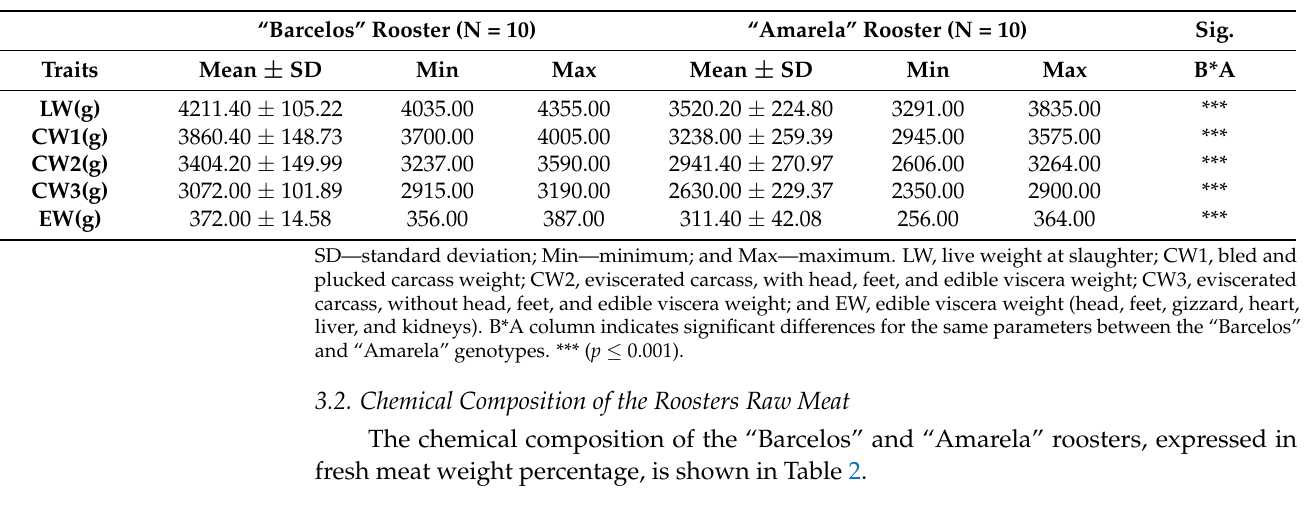
Table 2. Effect of breed and rooster pieces, breast, and drumstick in the chemical composition of “Barcelos” and “Amarela” roosters (expressed in % weight of fresh meat) (mean ± SD, Min and Max). “Barcelos” Rooster “Amarela” Rooster